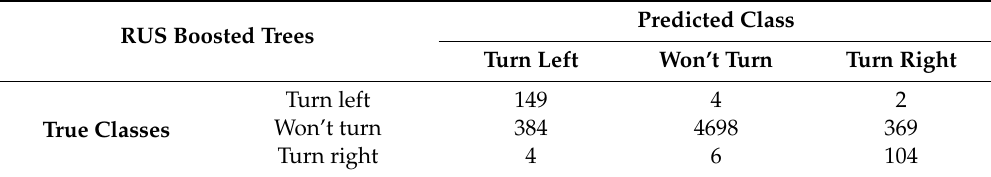
Table 3. The confusion matrix of the RUS boosted